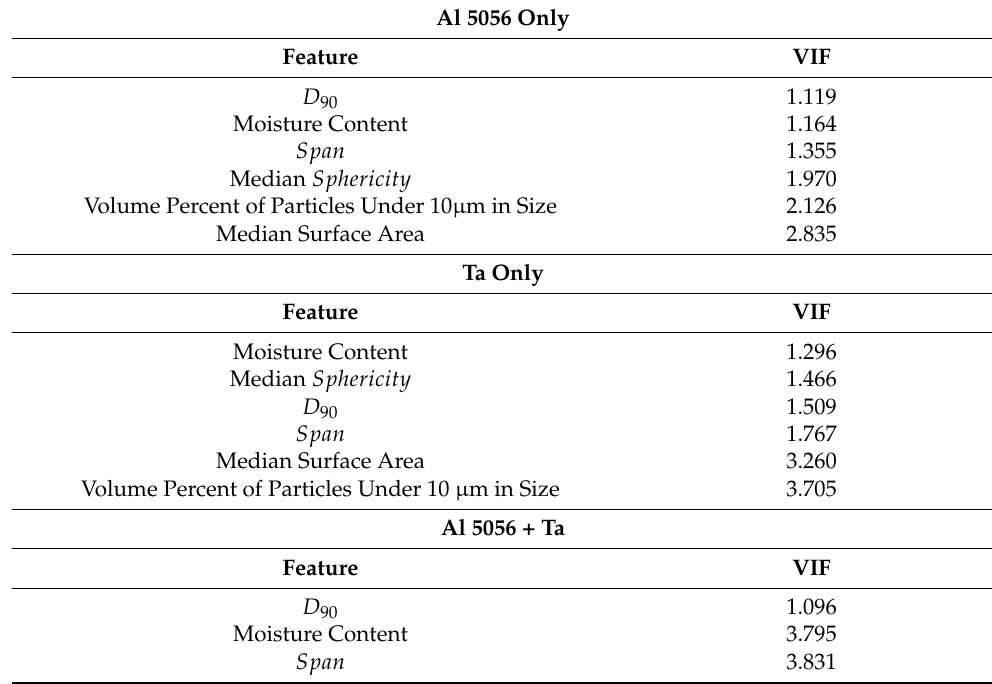
Table 3. VIF values of the Al 5056 Only, Ta Only, and Al 5056 + Ta datasets for feature screening for